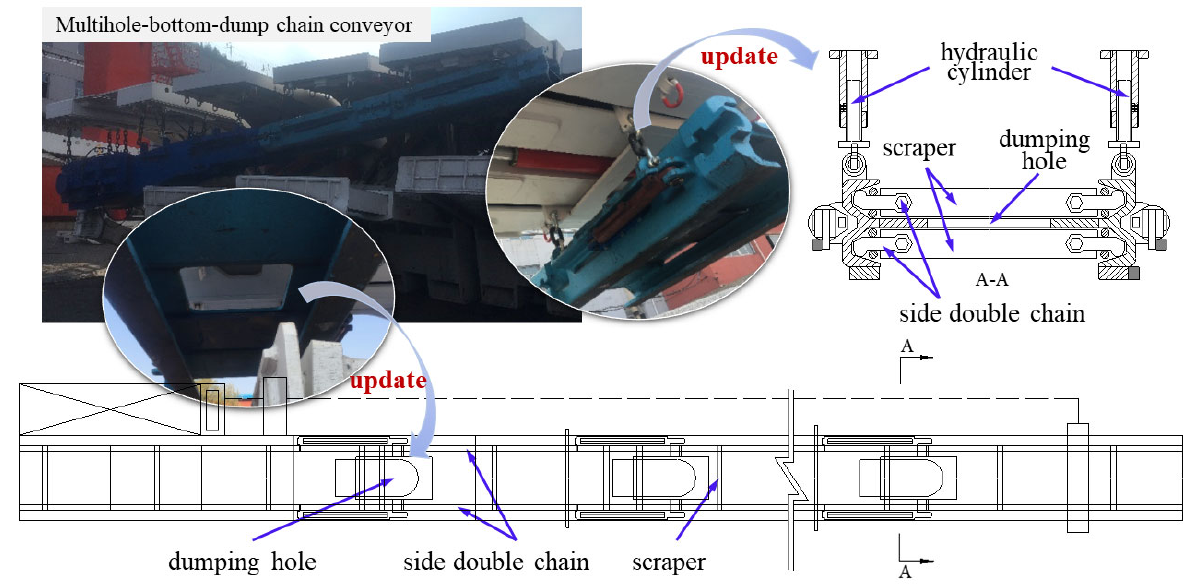
Figure 7. Schematic diagram of a novel type of multihole ‐ bottom ‐ dump chain conveyor.